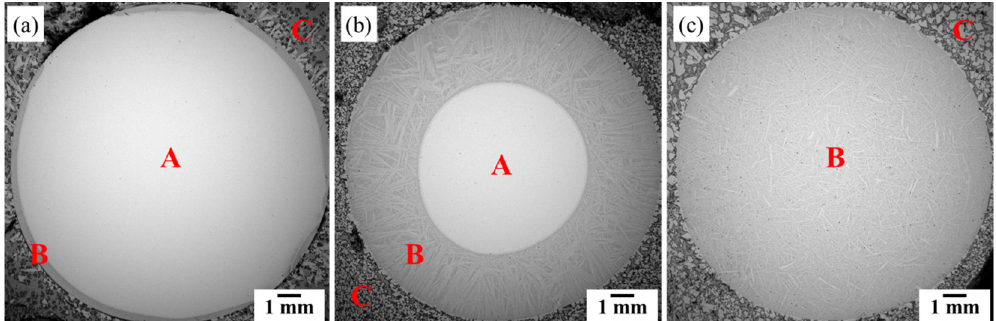
Figure 7. BSE images of the samples obtained from different temperatures: ( a ) 600 °C; ( b ) 750 °C; ( c ) 800 °C. A-Unreacted superalloy; B-Residual layer rich in Fe and Cr; C-Generated Mg-Zn-Ni alloy.